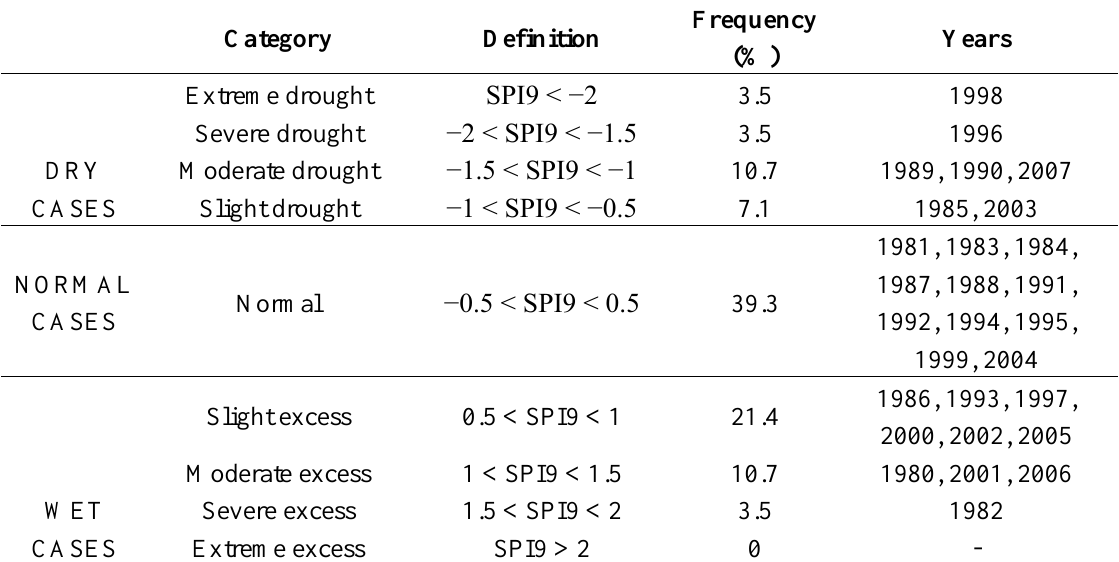
Table 1. Years classified using the value of SPI9. Percentage frequency is